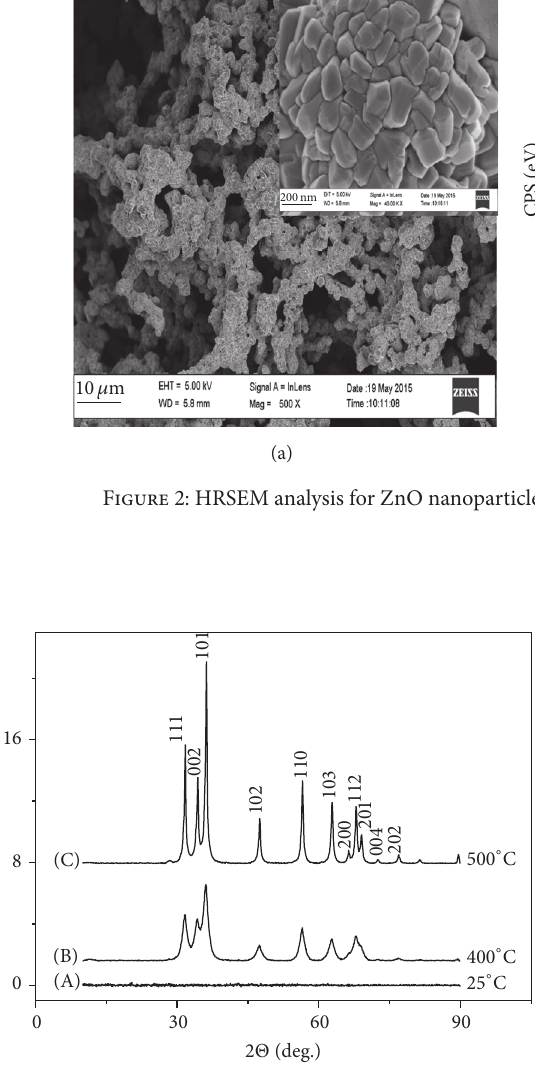
Figure 3: XRD spectra of ZnO nanoparticles (A) before annealing and (B, C) after